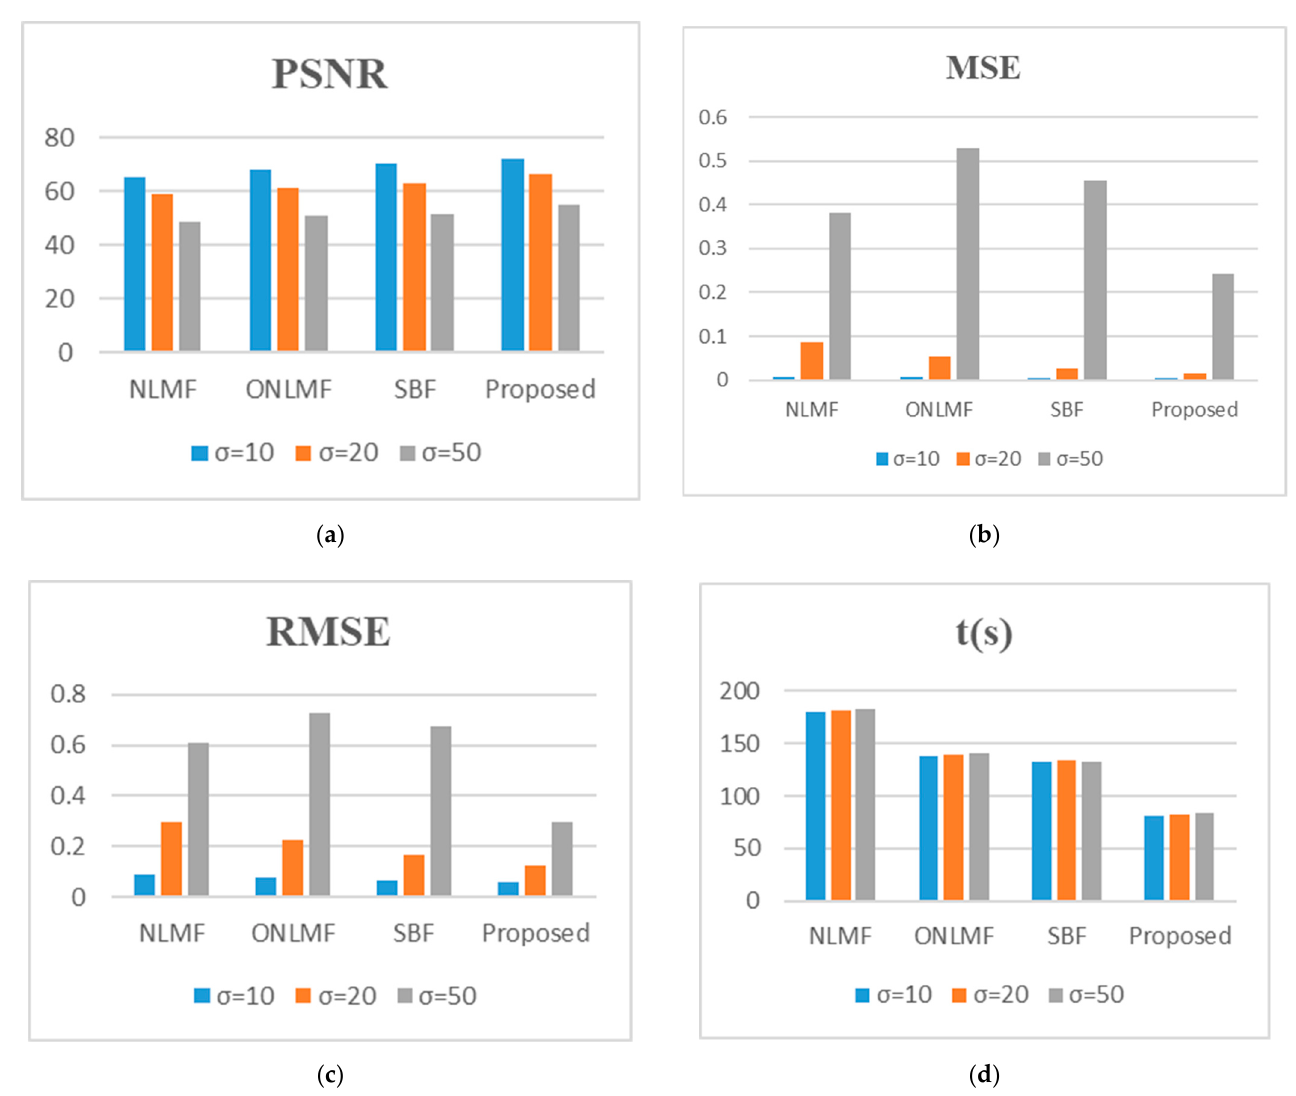
Figure 6. Average ( a ) PSNR; ( b ) MSE; ( c ) RMSE; ( d ) t(s) for several algorithms using private database images. NLMF, non-local means filter; ONLMF, optimized non-local means filter; SBF, switching bilateral filter; PSNR, peak signal-to-noise ratio; MSE, mean squared error; RMSE, root mean squared error; t(s), time in seconds; σ , Gaussian blur standard deviation.